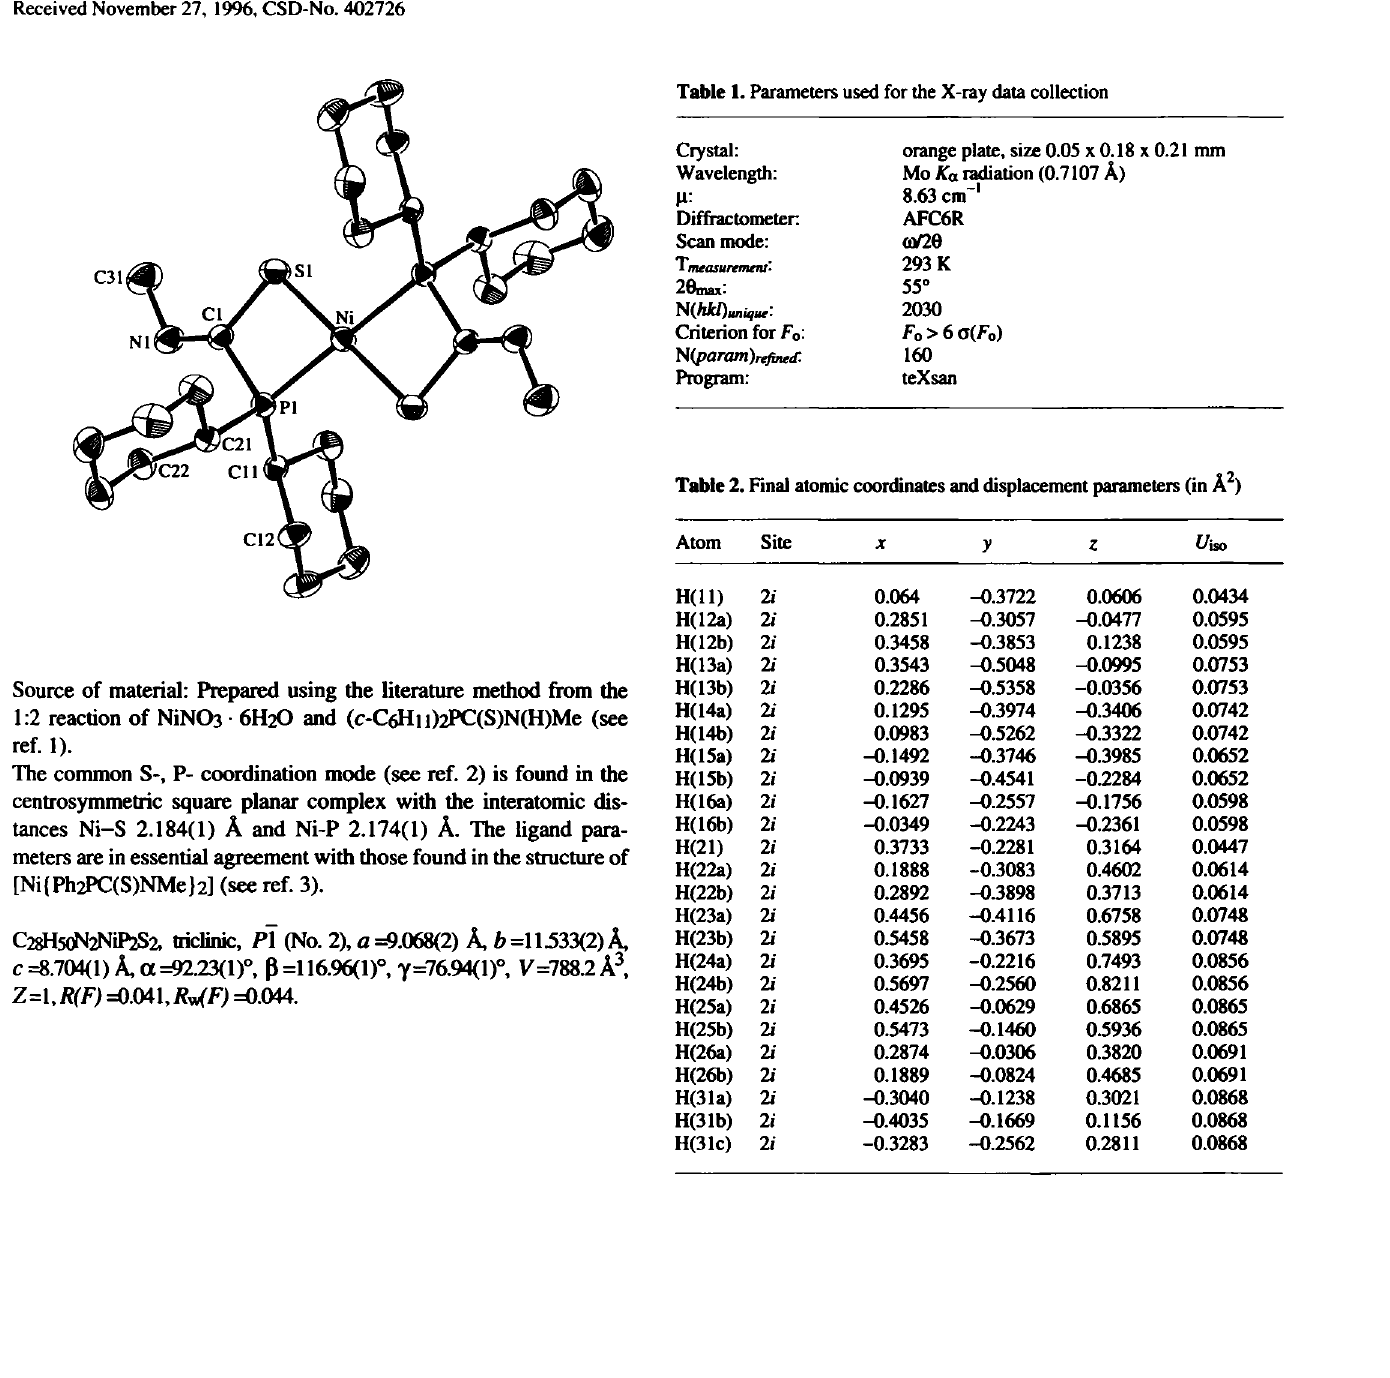
Table 2. Final atomic coordinates and displacement parameters (in Â 2